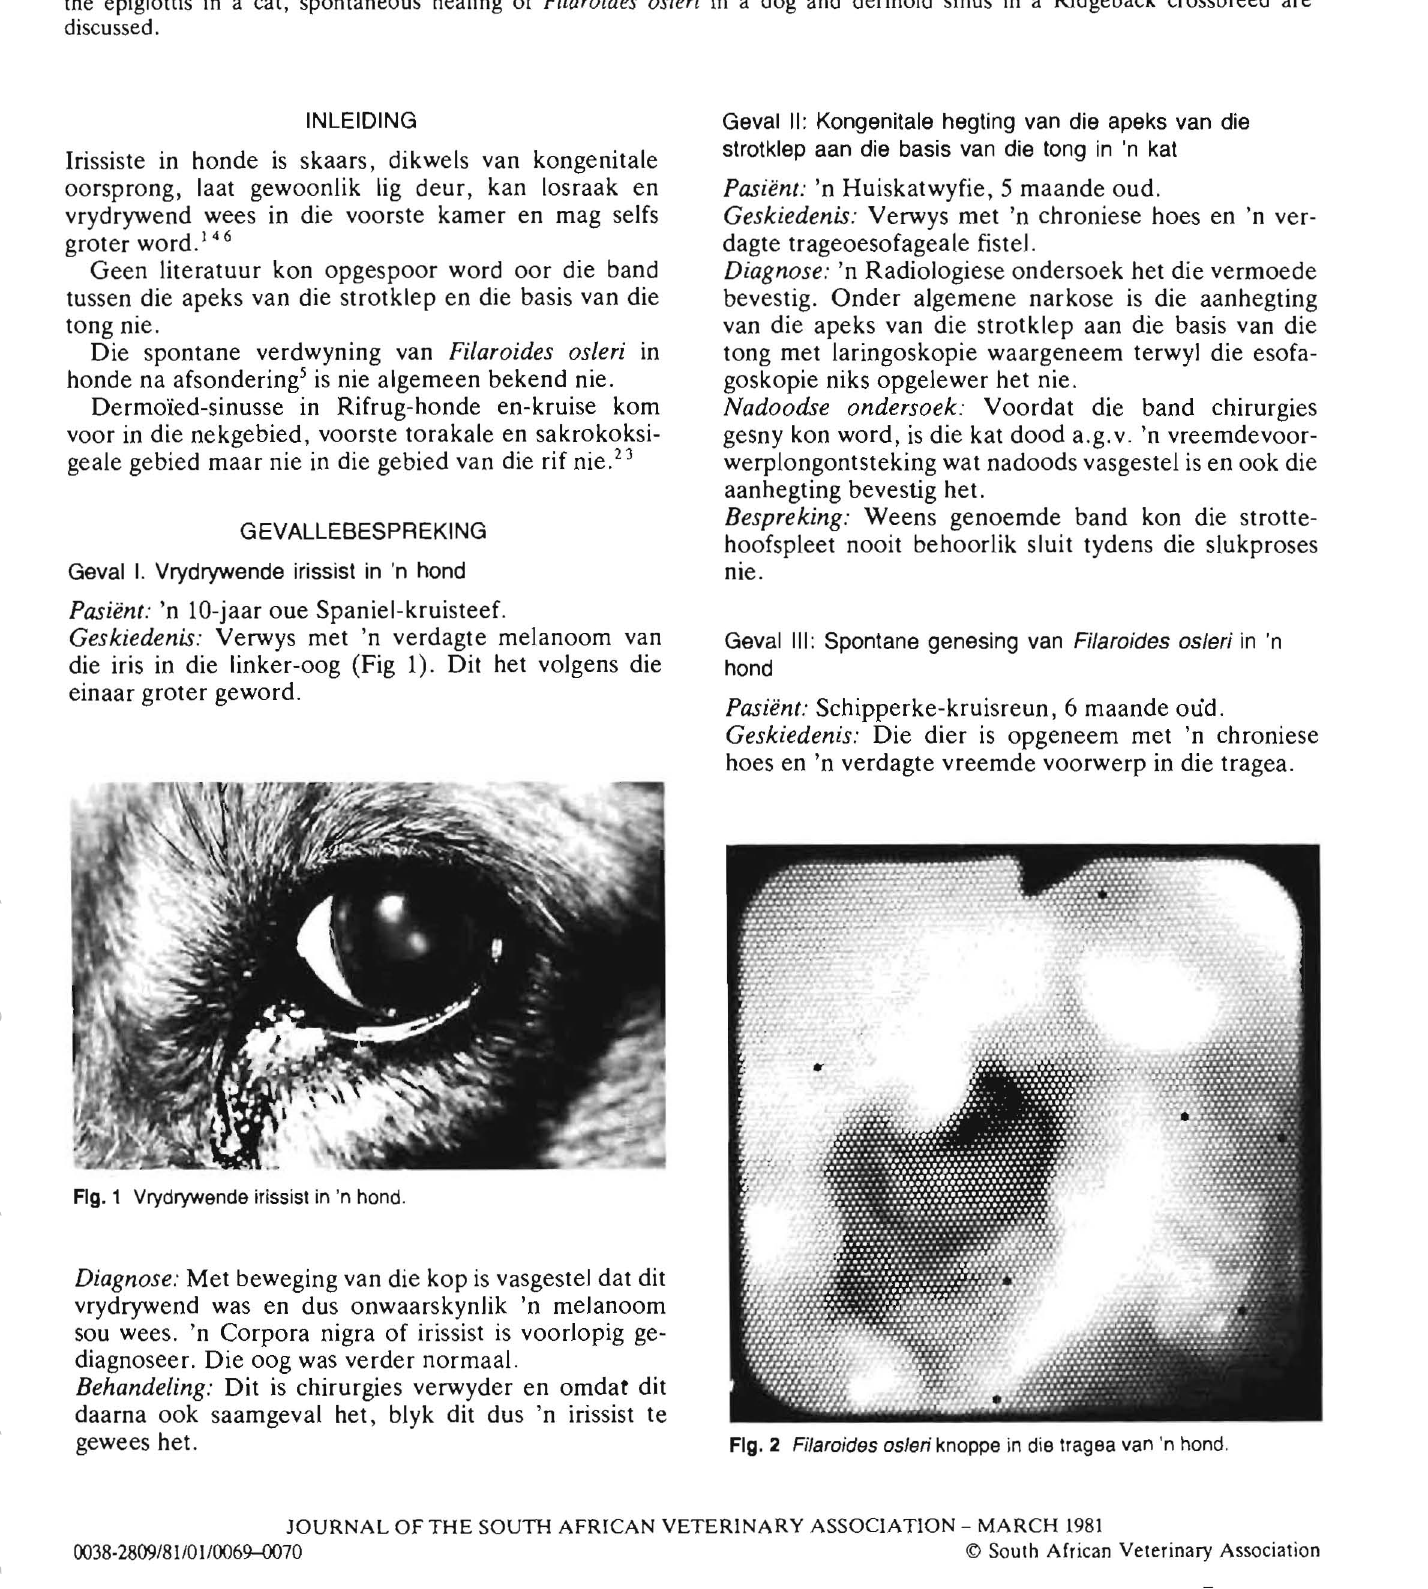
Diagnose: Met beweging van die kop is vasgestel dat dit vrydrywend was en dus onwaarskynlik 'n meJanoom sou wees. 'n Corpora nigra of irissist is voorlopig ge diagnoseer. Die oog was verder normaal. Behandeling: Dit is chirurgies verwyder en omdat dit daarna ook saamgeval het, blyk dit dus 'n irissist te gewees het. Fig, 2 Fi/aroides as/eri knoppe in die tragea van 'n